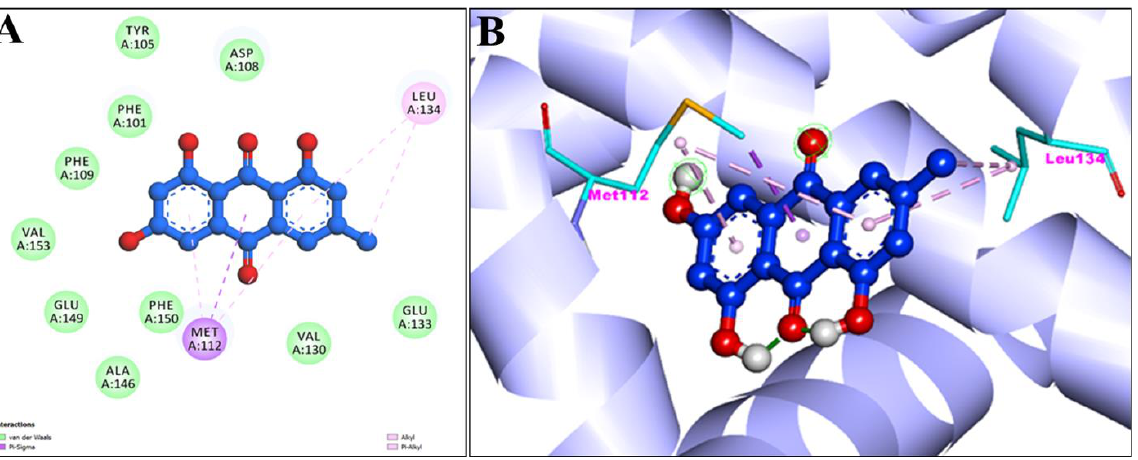
Figure 4. 2D ( A ) and 3D ( B ) representation of interaction of Emodin (blue color) and Apoptosis regulator Bcl-2 (purple color with ribbon pattern) (PDB:4MAN).